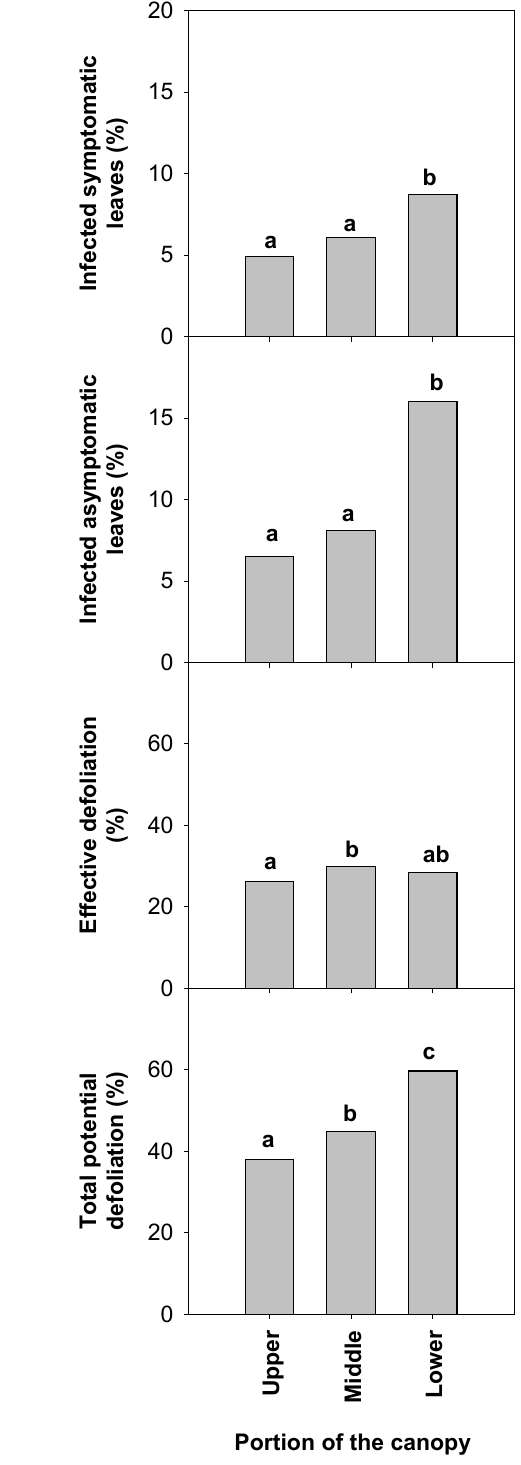
Figure 3. Means of olive tree defoliation and Venturia oleaginea infections as influenced by pruning. Means accompanied by the same letter are not significantly different ( P ≤ 0.05).